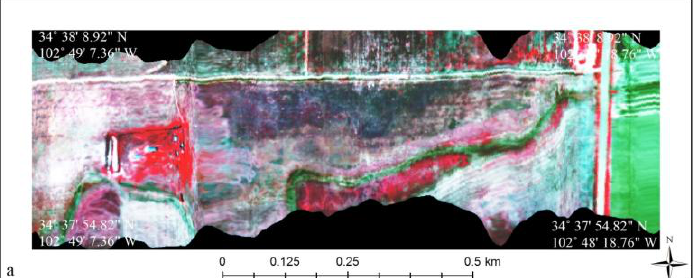
Figure 3. Color infrared hyperspectral imagery acquired in June 15, 2006 ( a ), classified image ( b ) and views of musk thistle infestation ( c , d ) at the study site. The entire area is native grassland, with the exception of a wheat field on the far right, right of the main